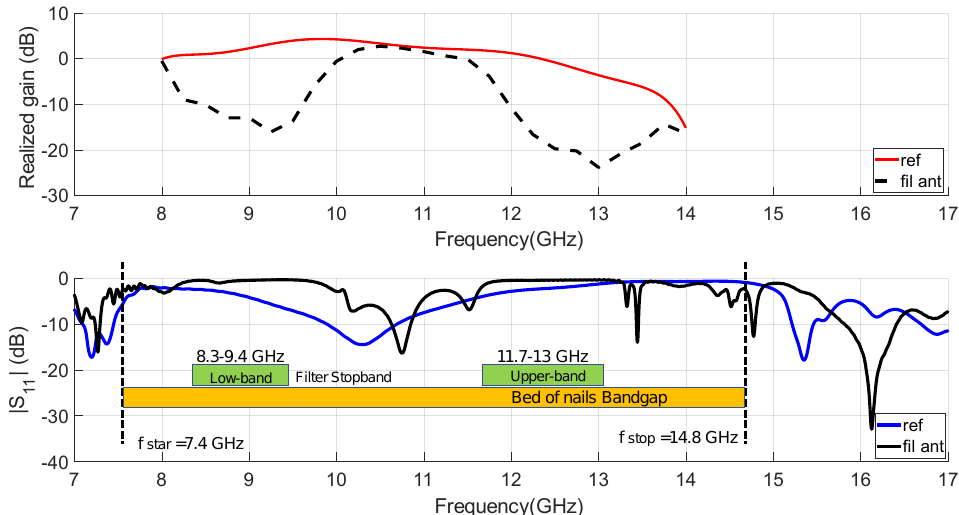
Figure 11. Simulated | S 11 | and broadside realized gain (at broadside) of the proposed IM-GWG filtering antenna in comparison with the slot